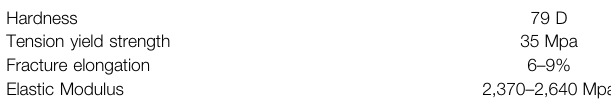
TABLE 1 | Material properties of modi fi ed pantographic ribs.